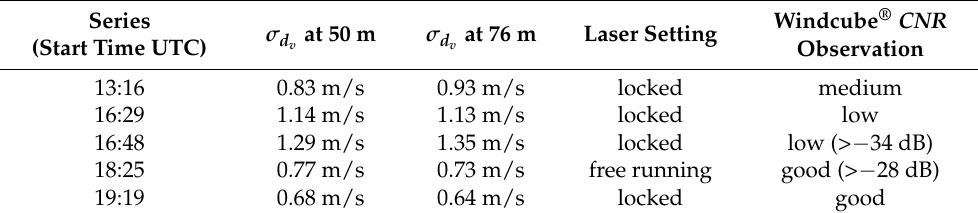
Table 4. Synopsis of the main wind comparison series on 29 January